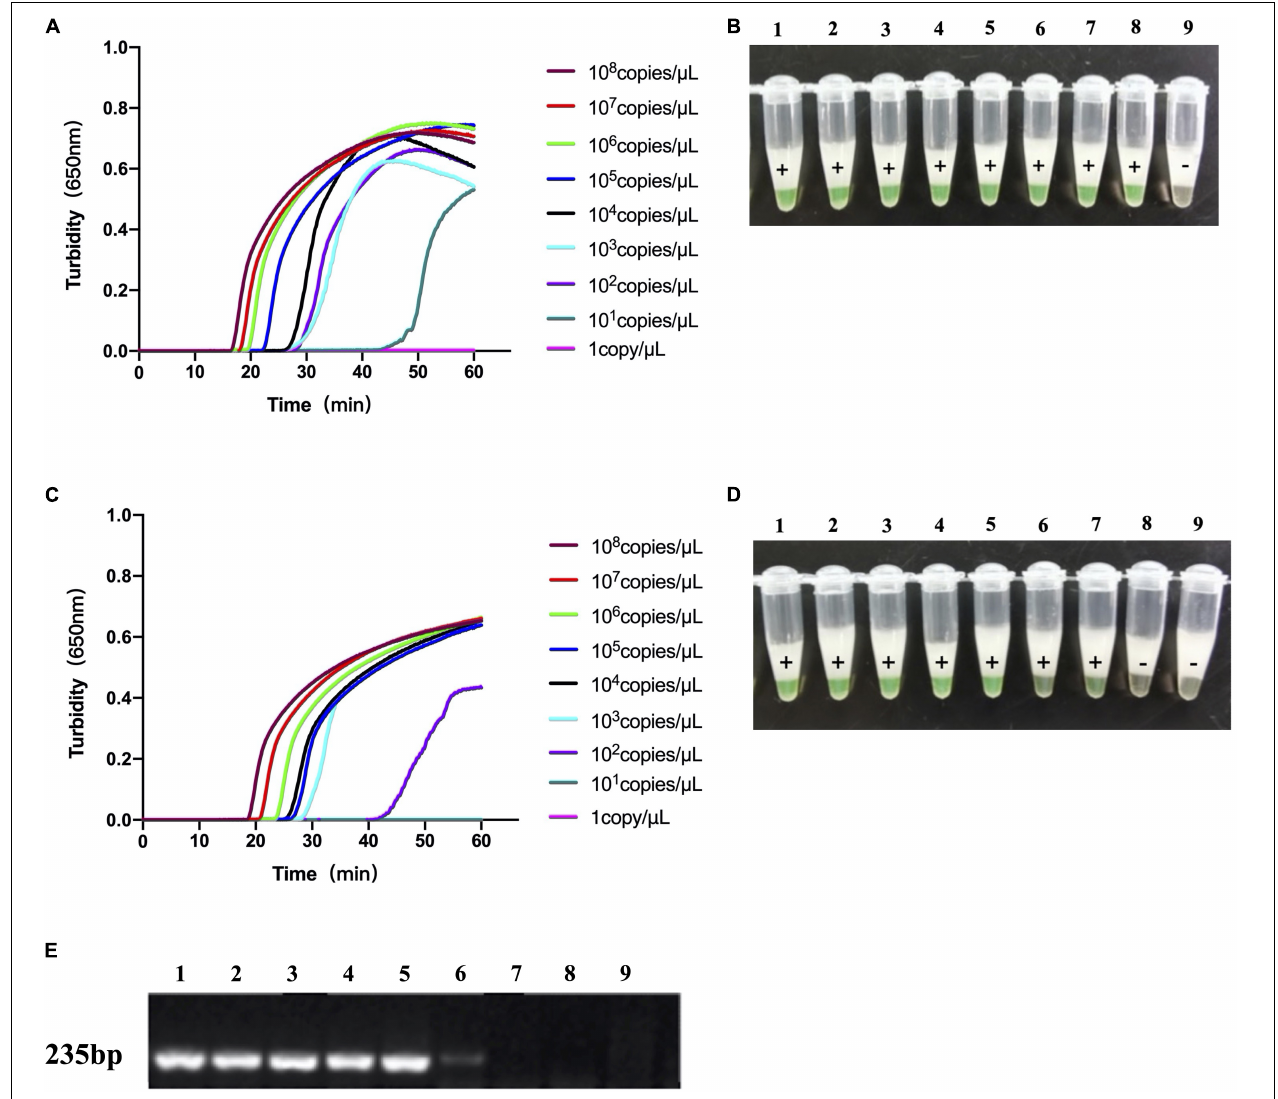
FIGURE 3 | The sensitivity of loop-mediated isothermal amplification (LAMP) analysis and conventional PCR to the detection of S. pneumoniae . (A,B) The sensitivity of LAMP analysis using the primer set LytA-1 to target the lytA gene. (C,D) Sensitivity of LAMP assay using primer set PsaA-2 to target psaA gene. (E) The sensitivity of conventional PCR detection for lytA and psaA gene. Use Loopamp real-time turbidity meter to monitor and detect turbidity (A,C) , and judge with the naked eye based on the color change from orange to green (B,D) . Lanes 1–9: 10 8 , 10 7 , 10 6 , 10 5 , 10 4 , 10 3 , 10 2 , 10 1 , and 10 0 copies/ µ